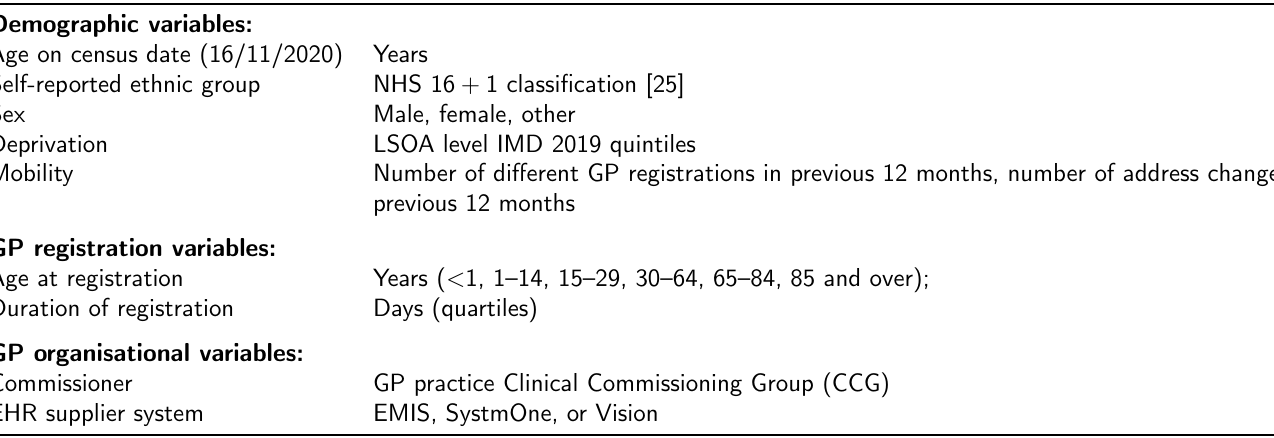
Table 3: The demographic, GP registration and GP organisational explanatory variables Demographic variables: